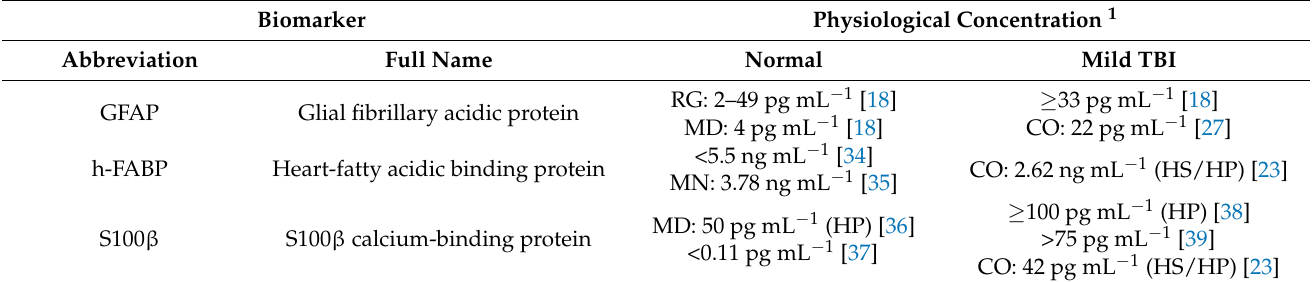
Table 1. mTBI protein biomarkers used in this work and their clinically relevant concentration